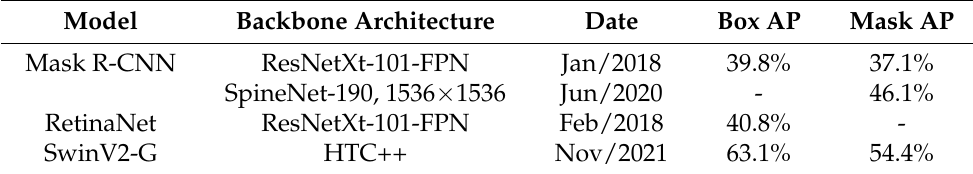
Table 1. Comparison table between the aforementioned methods on the COCO dataset